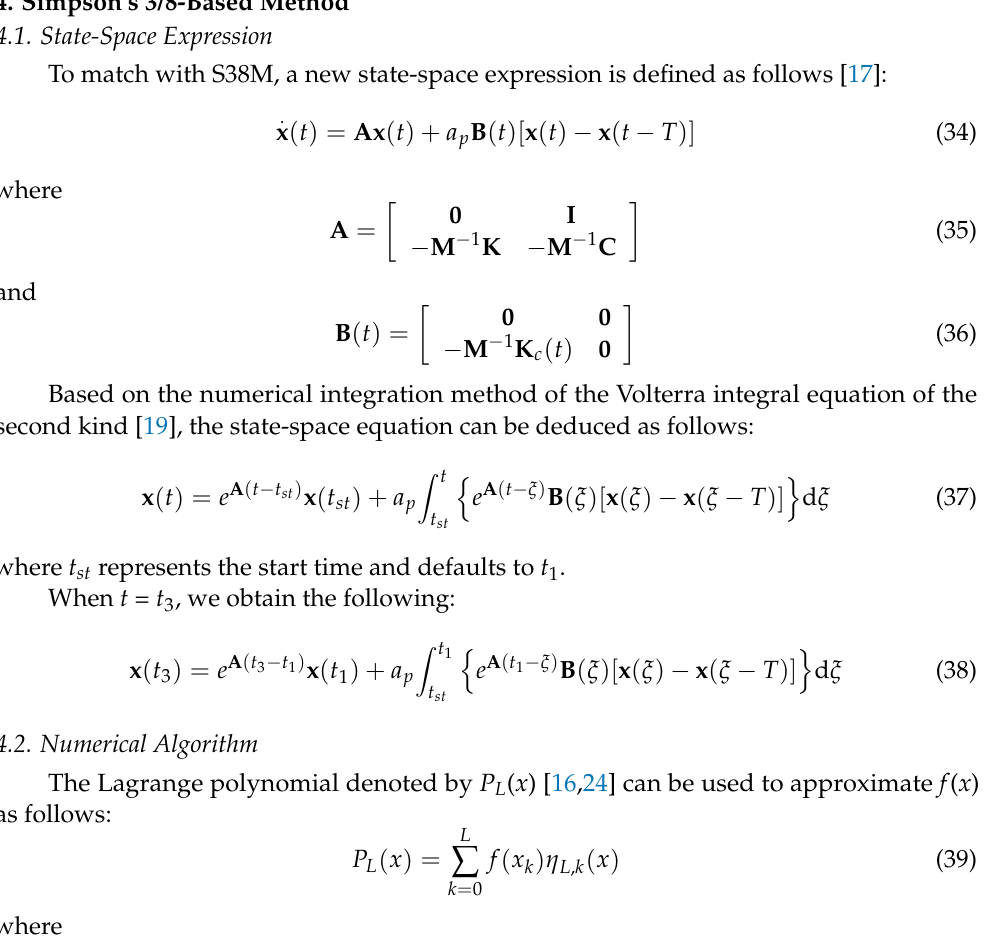
Figure 6. Computational time of the CCM, SDM, and SEM. ( a ) a / D = 0.05; ( b ) a / D = 0.5.